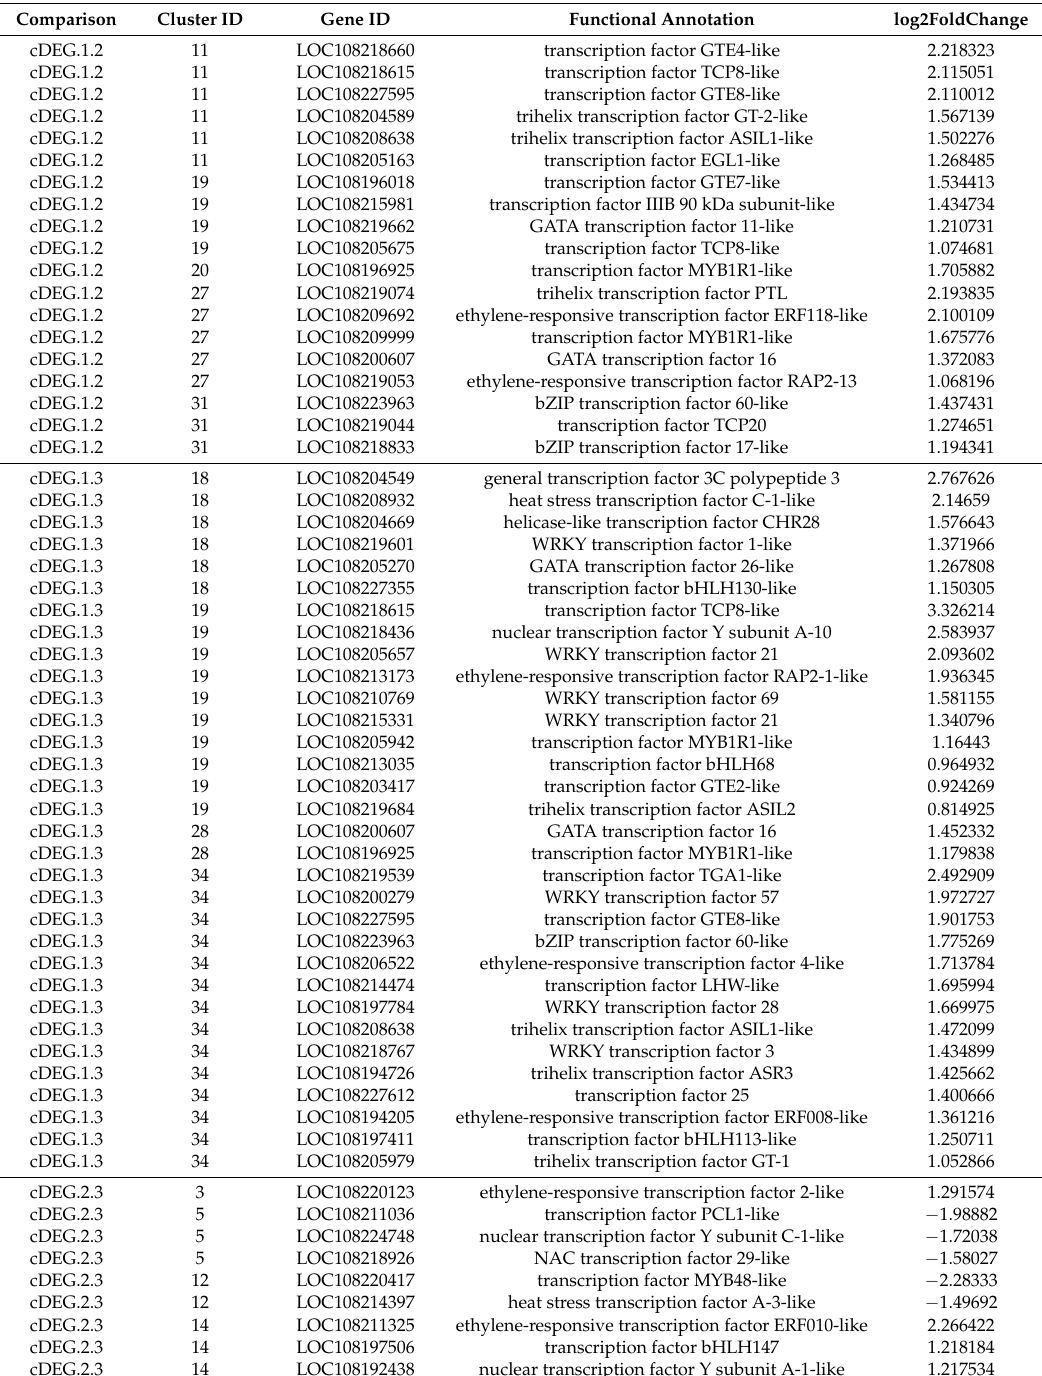
Table 2. Transcription factors differentially expressed in the cultivated